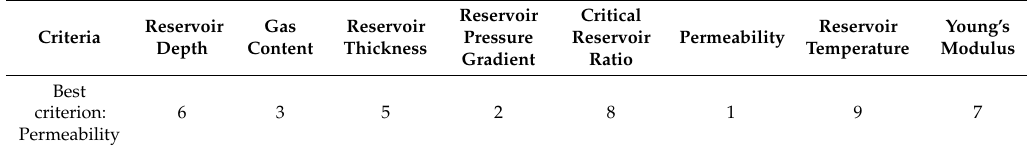
Table 2. Comparison vector for the best criterion.